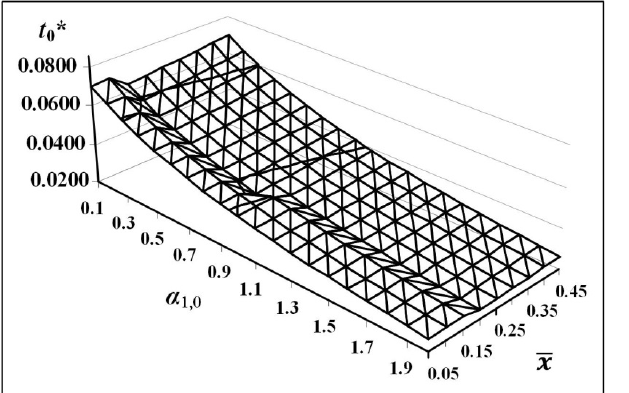
Fig. 17. The mutual effects on t 0 * regarding α 1,0 and mean x i Fig. 18. The combined impact on T A * relating to γ